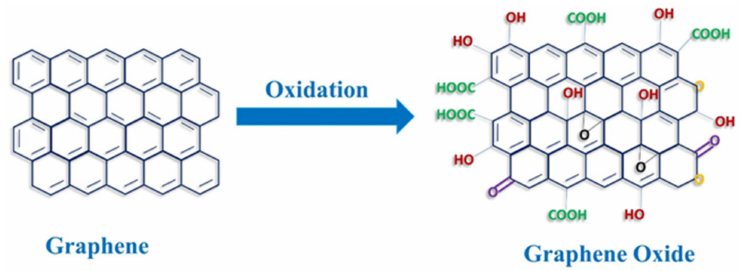
Figure 1. Chemical structure of graphene and graphene